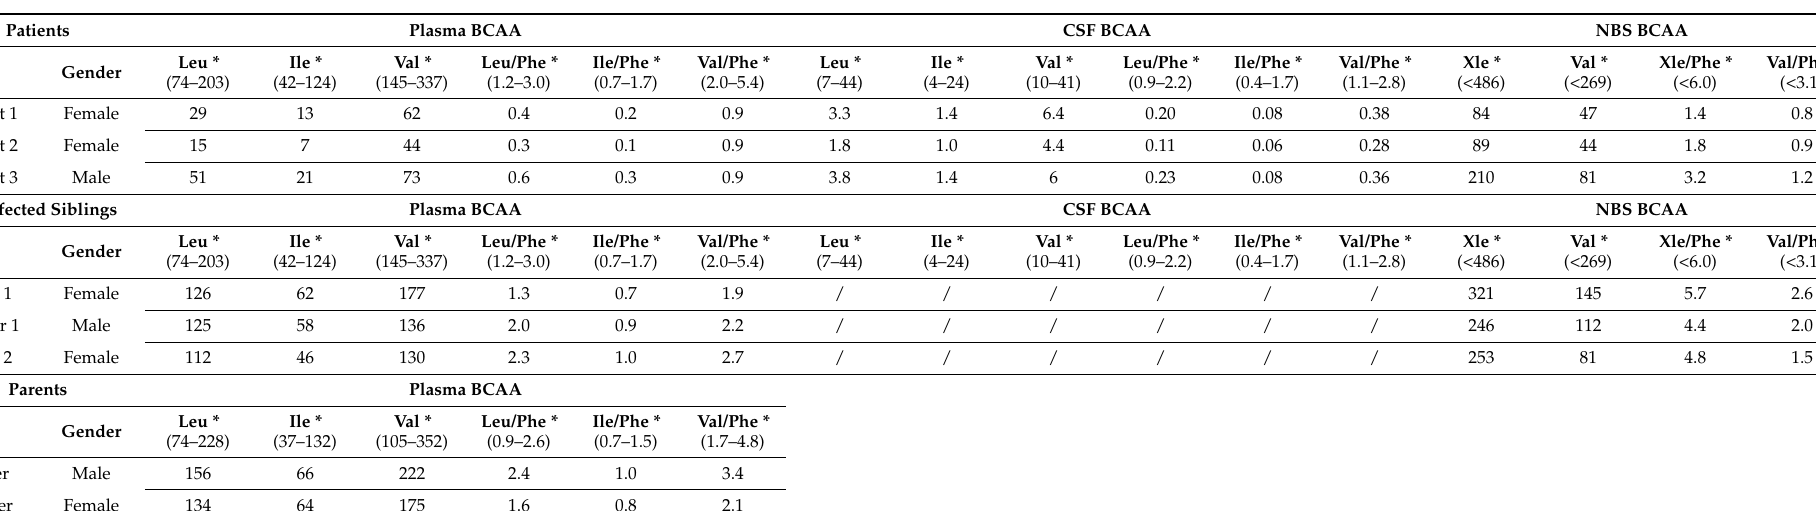
Table 1. Concentrations (in µ mol/L) and ratios of BCAA (with age-related reference values) measured in plasma, CSF and NBS dried blood cards of affected patients and their relatives. Plasma and CSF concentrations of patients are reported at time of